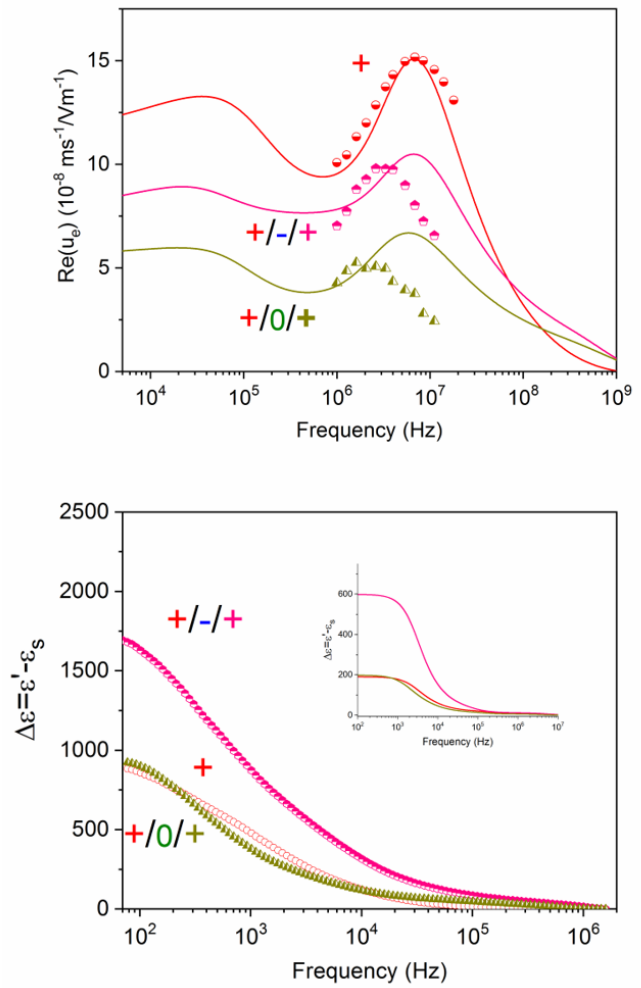
Figure 12. Real part of the dynamic mobility (top) and dielectric increment (bottom) of suspensions of polystyrene particles coated by PDADMAC (+), PDADMAC/PSS/PDADMAC (+/ − /+), and PDADMAC/PEO/PDADMAC (+/0/+).